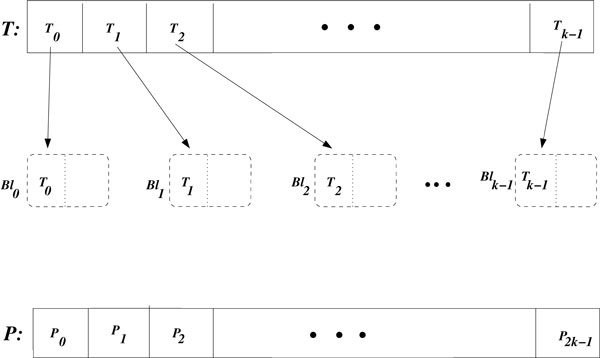
Matrices partitioning. Partitioning the matrices T and P in k segments and blocks access to segments of T: an arrow Ti→ Bliindicates that the block Bliaccesses the segment Ti.